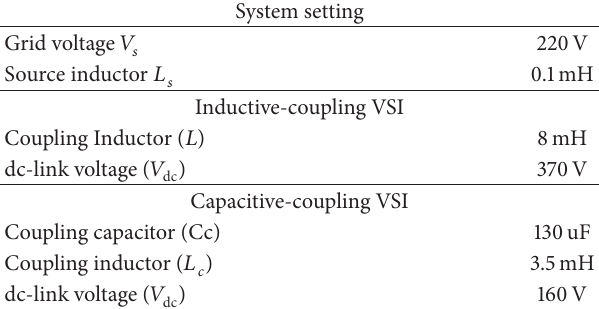
Table 3: System parameters in the